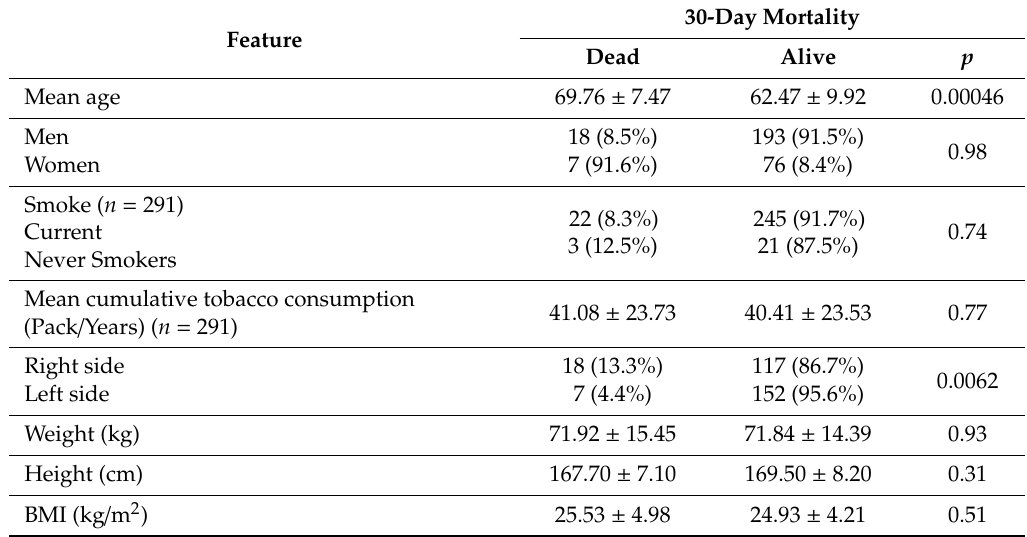
Table 4. Correlations between patient’s and tumor related factors with postoperative